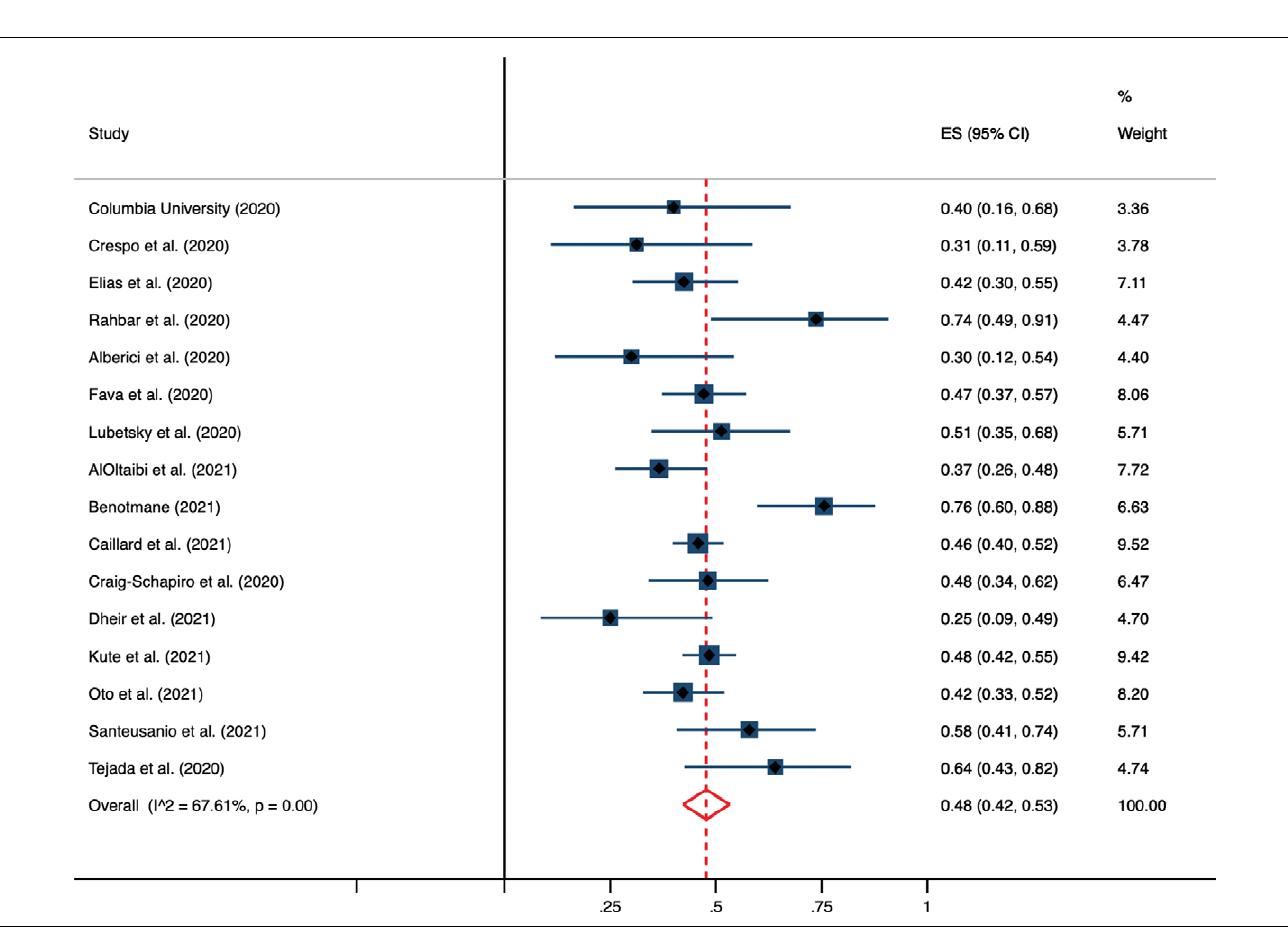
Figure 5. Pooled estimate on AKI rate of kidney transplant recipients with COVID-19 infection.